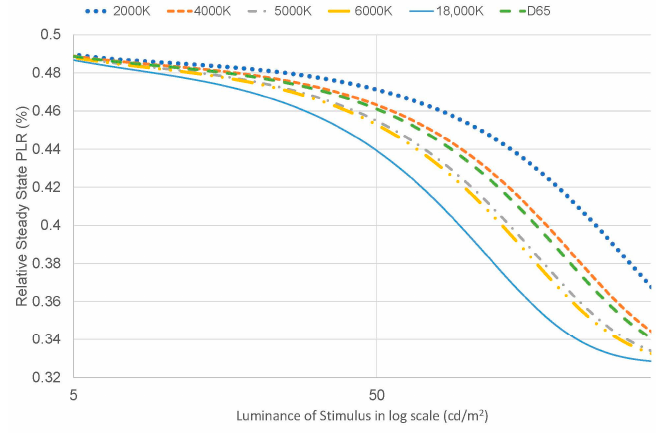
Figure 11. Calculated relative steady-state PLR with Formula (6) vs. luminance of stimulus with di ff erent spectra.